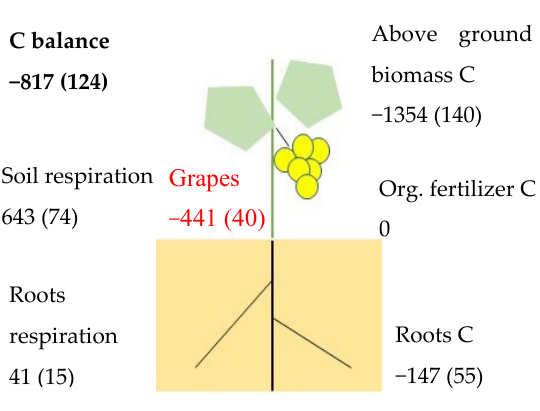
Figure 2. Carbon balance in Xynisteri vines (average values in kg C ha −1 and standard deviation in parenthesis; n = 3). Berries (grapes; red color) are not included in the C balance as they are removed from the system at harvest. A negative value indicates C uptake and a positive C release.